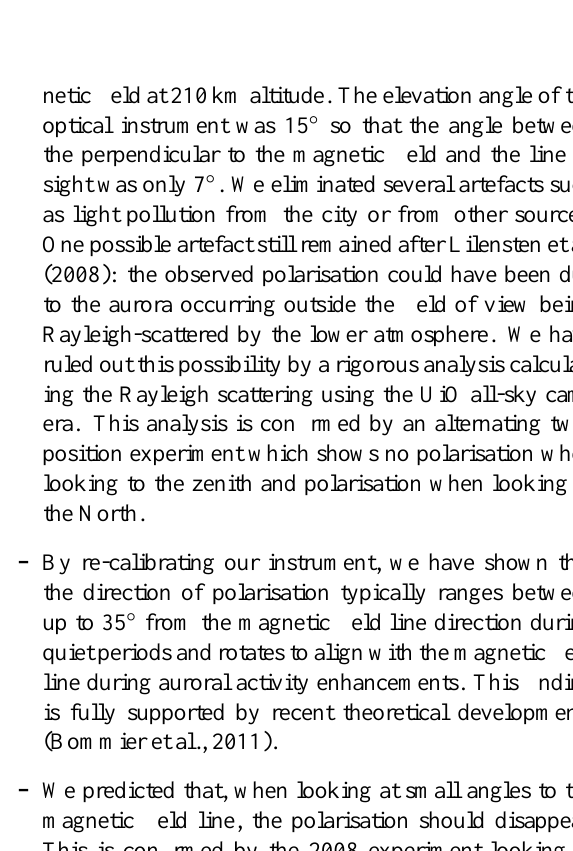
Fig. 11. ESR 32m dish – southward observations. Upper panel represents N e (log ( N e ) with N e in m − 3 ), second T e (K), third T i (K), and fourth V i (ms − 1 ). Altitudes are in